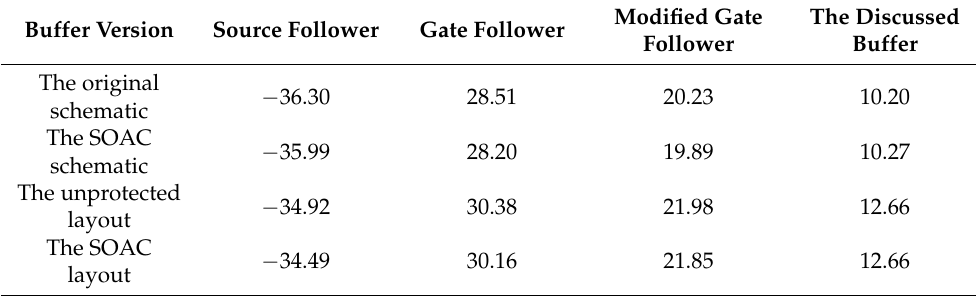
Table 7. Comparison of output to input DC offset [mV] comparison for different implementation stages of the source follower, gate followers, and discussed